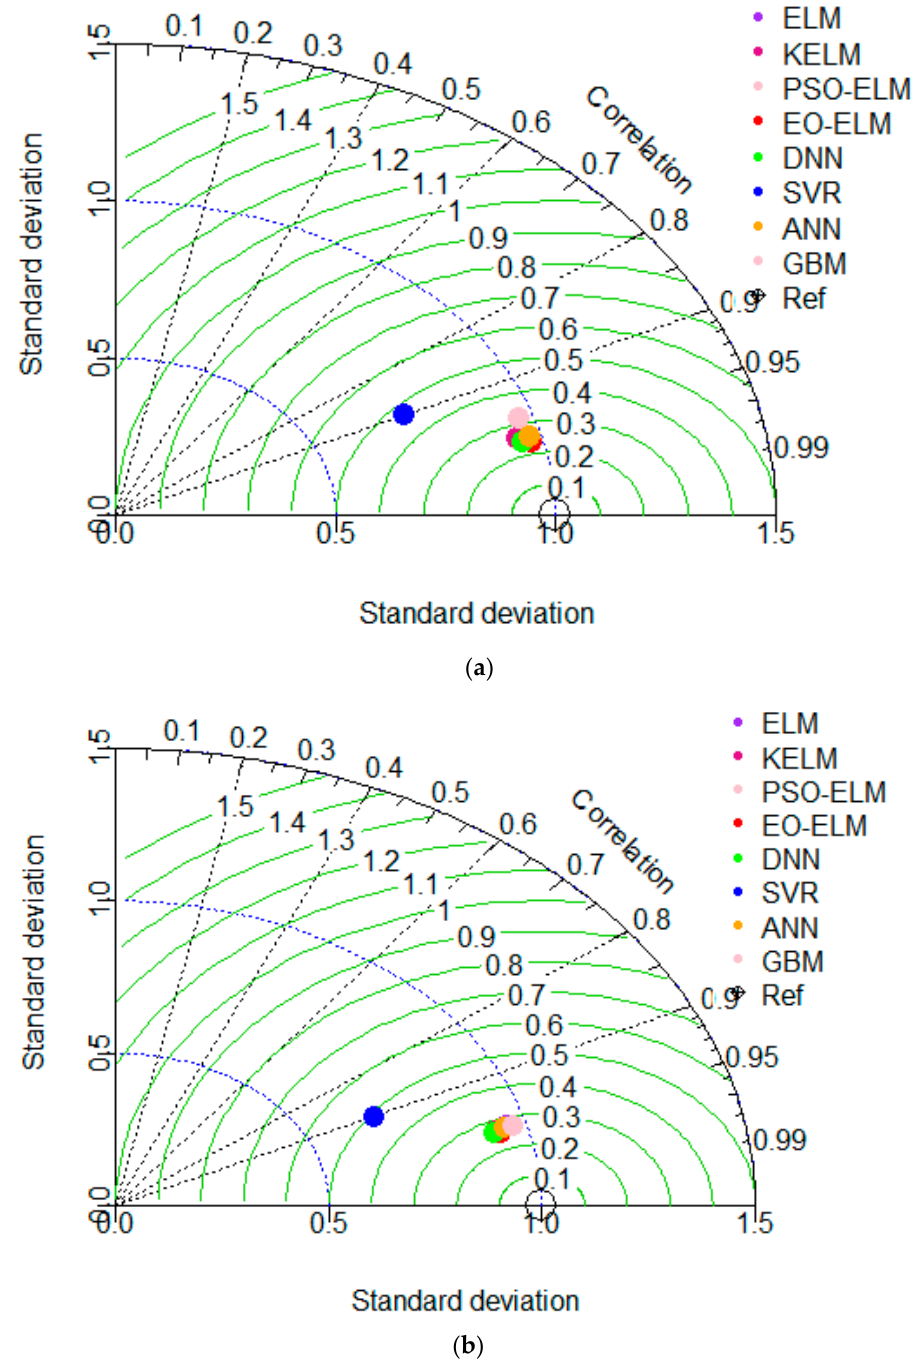
Figure 13. Statistical comparison for all models for catchment Teifi at Glanteifi: ( a ) train and ( b ) test. In the initial period (PACF-based selected lags) of model development, models give The performance of the wavelet-based models for the catchment Fal at Tregony a distinct predictive performance for the two different catchment sizes, and characteristics